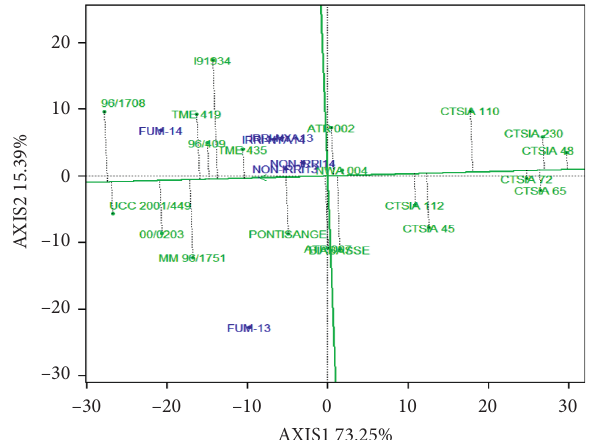
Figure 5: Comparison biplot for storage root yield of 20 cassava genotypes in six environments. FUM-13 � Fumesua 2013, NON- IRRI13 � no irrigation 2013, IRRI-NYA13 � irrigation 2013, FUM- 14 � Fumesua 2014, NON-IRRI14 � no irrigation 2014, and IRRI- NYA14 � irrigation